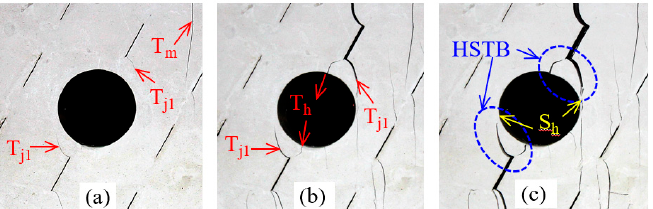
Figure 11. Cracking process around the hole in specimen HC60 of collapse mode III h at: ( a ) σ 1 = 0.96 σ p , ε 1 = 0.96 ε p ; ( b ) σ 1 = 0.85 σ p , ε 1 = 1.13 ε p , and ( c ) σ 1 = 0.38 σ p , ε 1 = 1.46 ε p .